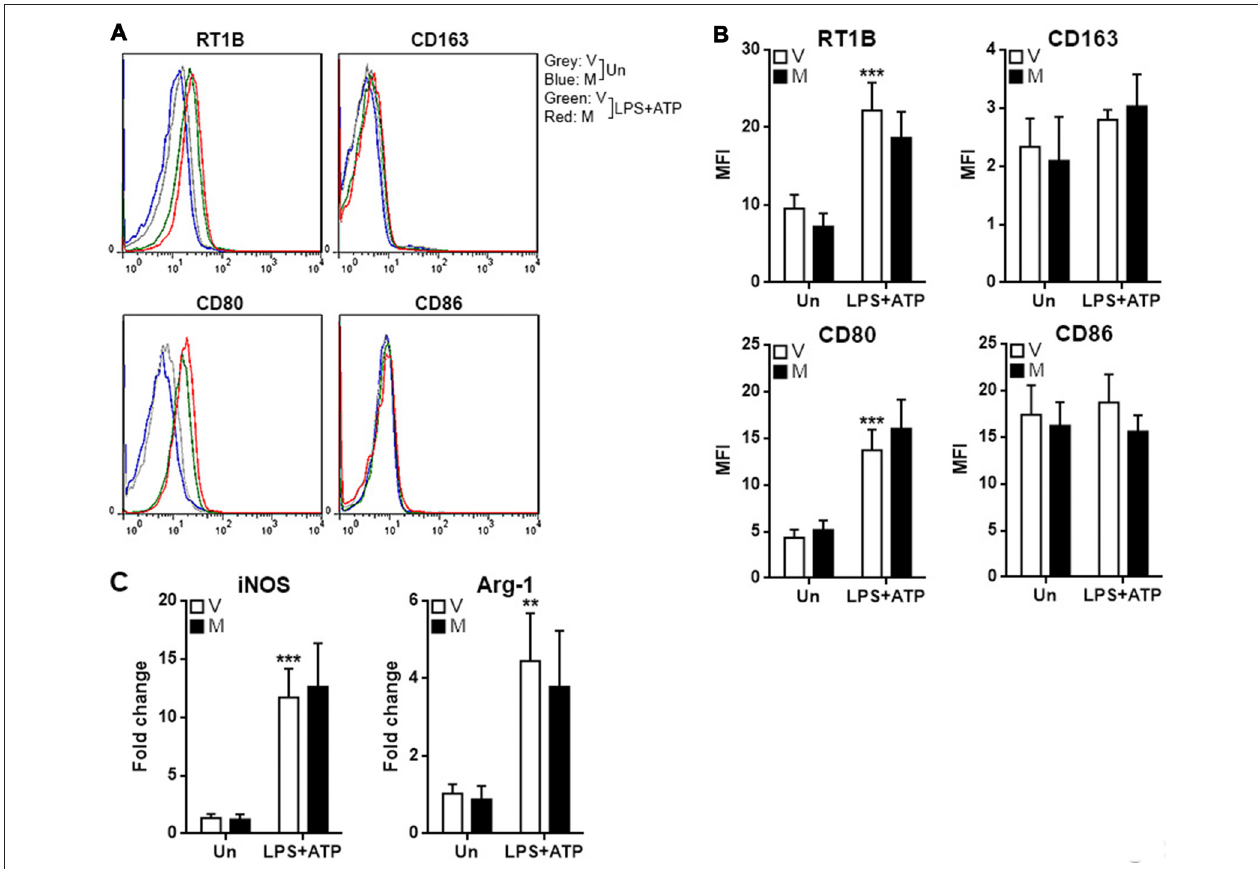
FIGURE 2 | Methylene blue does not alter the expression of M1 and M2 markers. (A,B) Expression of indicated surface markers on cultured microglia. Representative flow cytometry histograms are shown in (A) , and statistics is shown in (B) . (C) mRNA levels of iNOS and Arginase-1 in cultured microglia. Un: no stimulation. LPS+ATP: stimulation with LPS followed by ATP treatment. V, vehicle; M, 500 nM methylene blue. ∗∗ p < 0.01; ∗∗∗ p < 0.001 in comparison with unstimulated cells of the vehicle group. N = 4 per